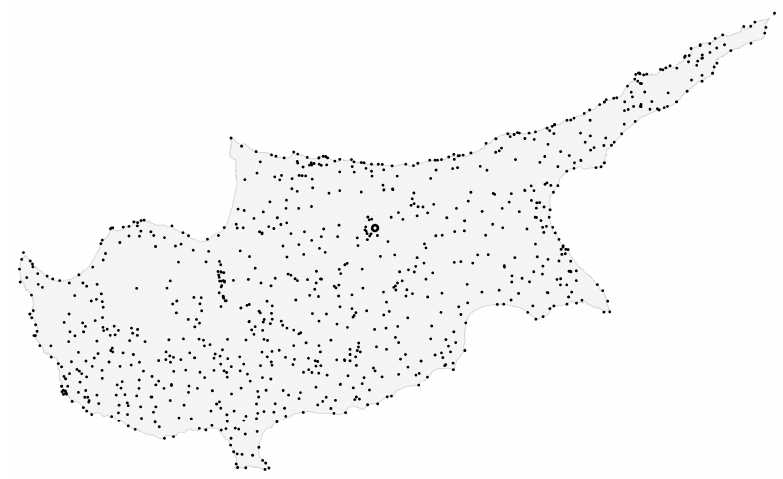
Figure 3. The distribution of control points used in the georeferencing process.